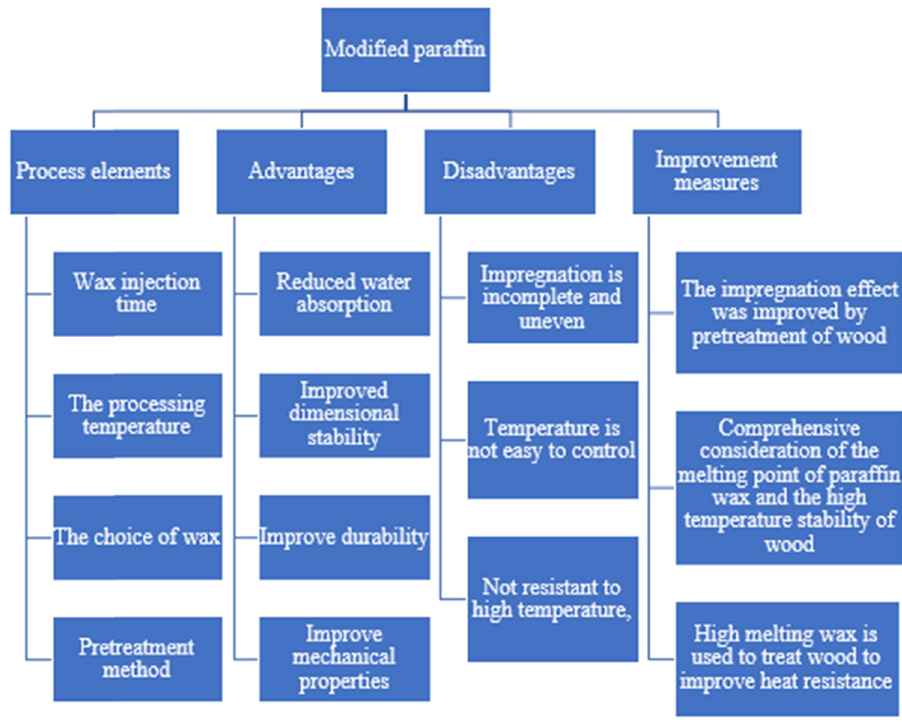
Figure 15: Para ffi n modi fi cation process elements, advantages, and disadvantages, and improvement